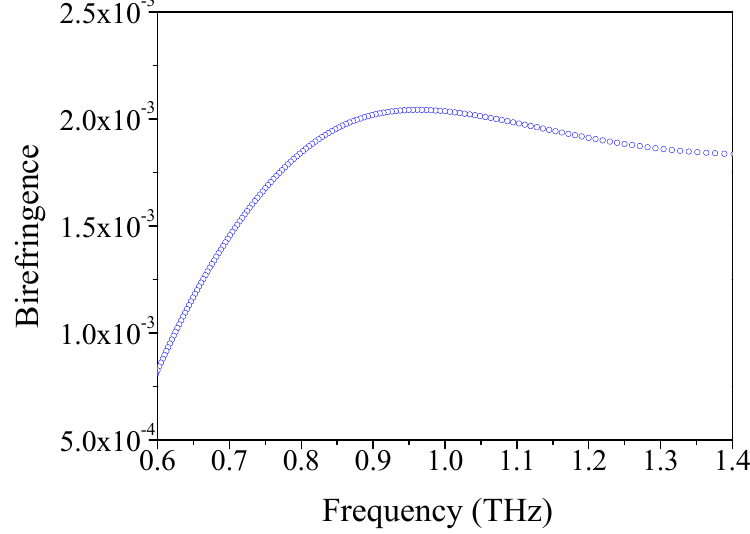
Figure 7. The relation of birefringence with frequency.